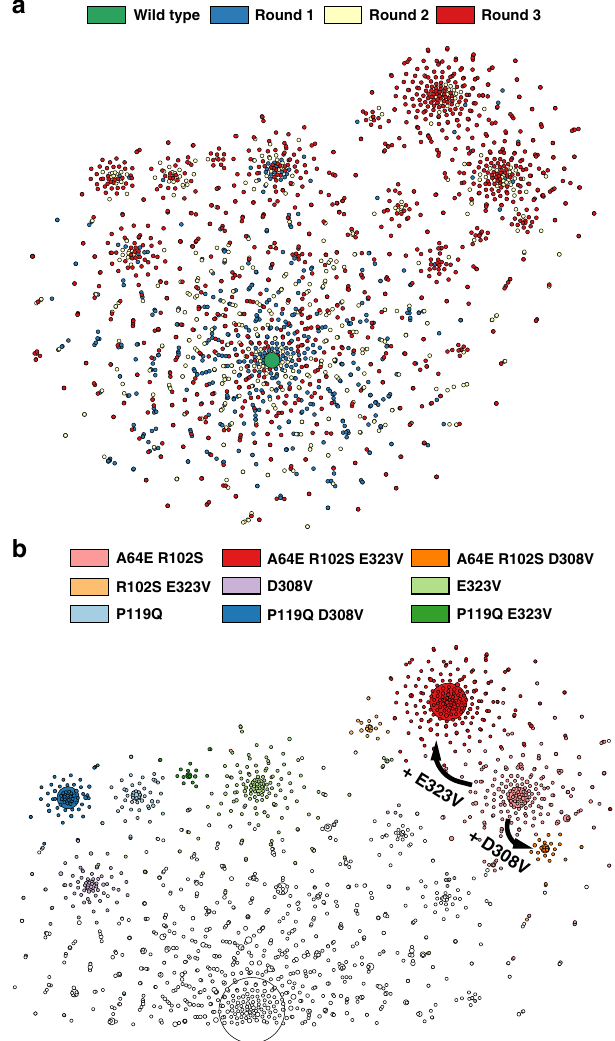
Fig. 3 Phylogenetic analysis of directed evolution in sequence similarity networks. a Full graph color coded by the round of evolution in which mutant sequences were fi rst recorded. A graphical representation (with t- Distributed Stochastic Neighbour Embedding, tSNE) of variants identi fi ed in droplet screening illustrates possible trajectories in a fi tness landscape: spots represent all unique variants identi fi ed within the pools of hits. Distinct clusters emerge over the course of evolution, as indicated by the color code showing the round of fi rst emergence of each sequence. Size of wild type increased for visualization. b Analysis of founder variants. Part of the sequence similarity network is shown with the color indicating the corresponding core set of mutations that they share with the ‘ founder variant ’ , so that these mutations are present in all variants within the cluster. Spot sizes correspond to total sequence count of the respective variant. The clusters are de fi ned by multiple mutations and thus can only be inferred based on long sequence reads that inform phylogeny of possible trajectories during experimental directed